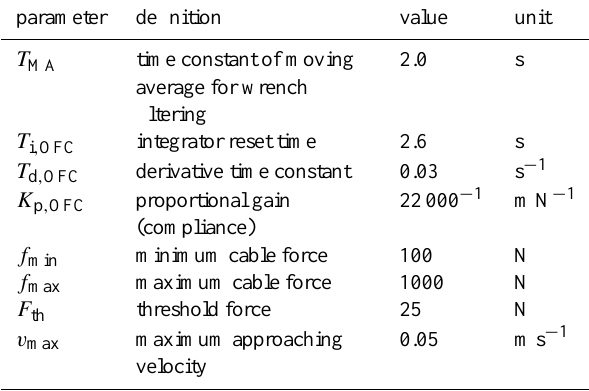
Table 1. Control parameters of hybrid position-force control (con- troller is experimentally